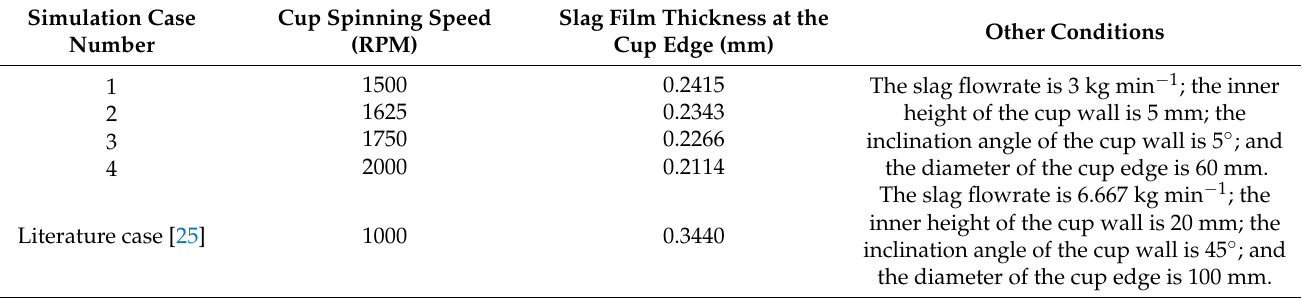
Table 2. Computation scheme for the present cases and literature